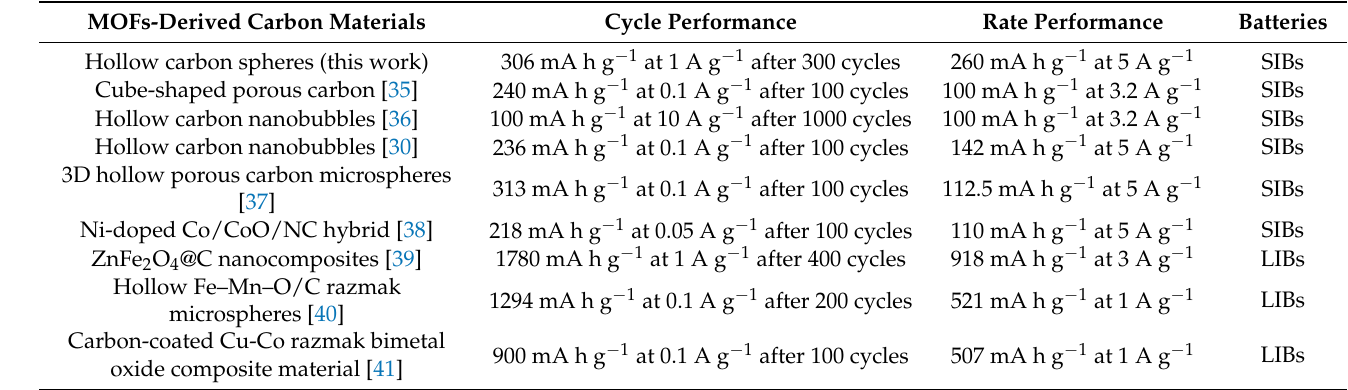
Table 1. Electrochemical performances of MOFs-derived carbon materials for the anode materials of SIBs and